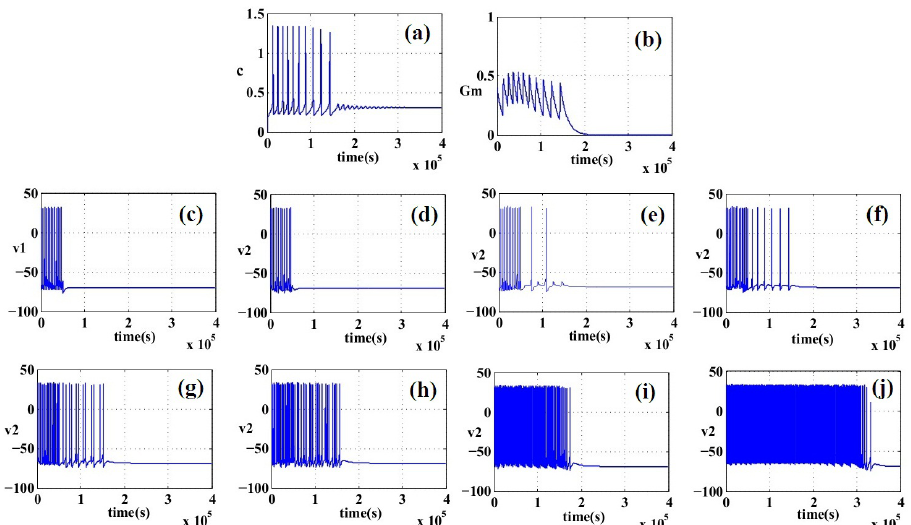
Figure 7. Closed-loop behavior in the neural glial interaction. ( a ) Calcium dynamic. ( b ) Astrocyte mediator (glutamate). ( c ) Spiking activity of pre-synaptic neuron. ( d – j ) Spiking activity of post- synaptic neuron based on different values of γ . By increasing γ , the intensity of neural activity has been